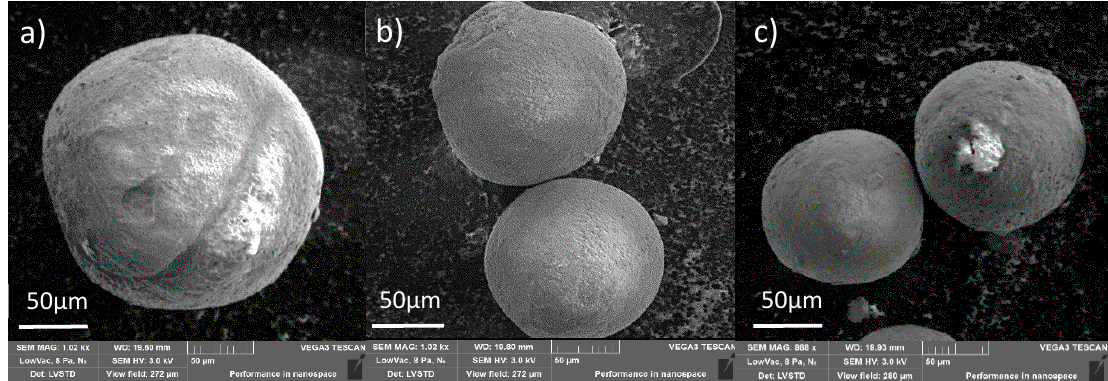
Figure 4. Scanning electron microscopy (SEM) images of obtained microspheres: ( a ) terpolymer, ( b ) TER/dextrin ( c ) TER/maltodextrin (magnification × 1000).